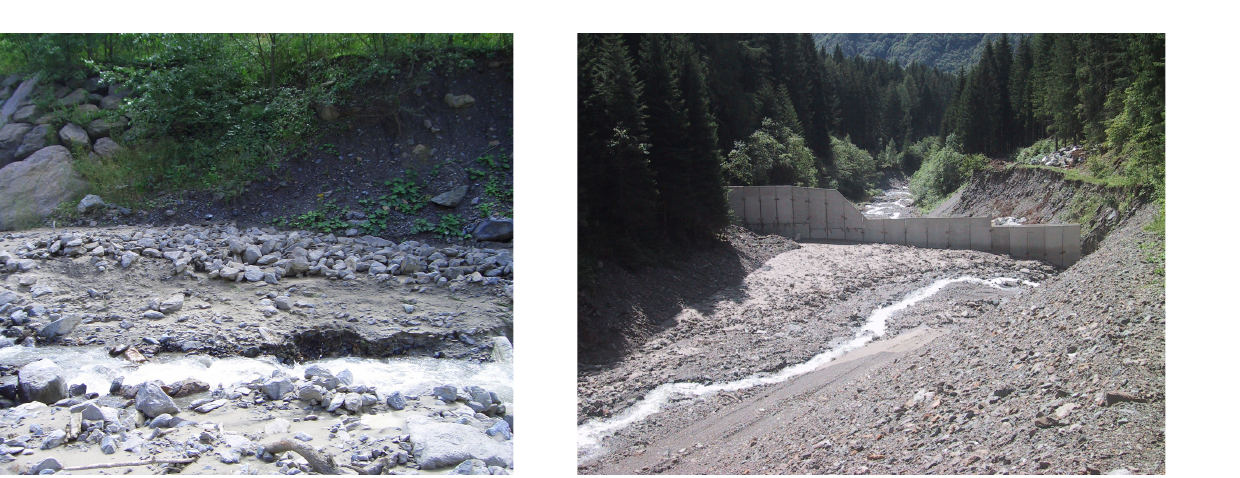
Fig. 7. Fresh debris-flow deposits above the partially built check dam near the sensor S1 (see Fig. 2 for